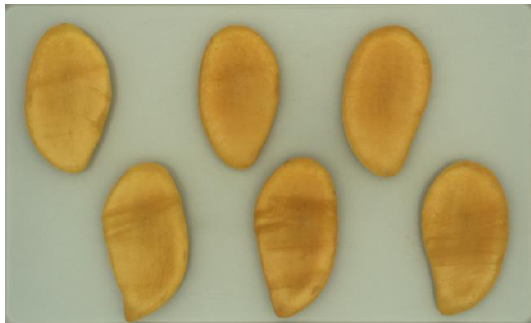
Figure 1. Slices of “ Nam Dokmai ” mango for evaluating the pulp color in the computer vision system.